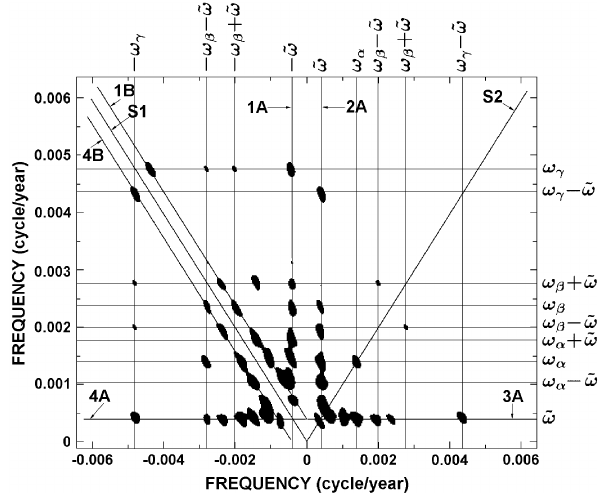
Fig. 4. The modulus of bispectrum for the radiocarbon series 1 14 C D . Dark spots denote spectrum peaks. The lines S1 and S2 are the symmetry axes of the left side ( ω x < 0) and the right side ( ω x > 0), respectively. The abscissae of vertical lines 1A and 2A correspond to the ∼ 2400-year